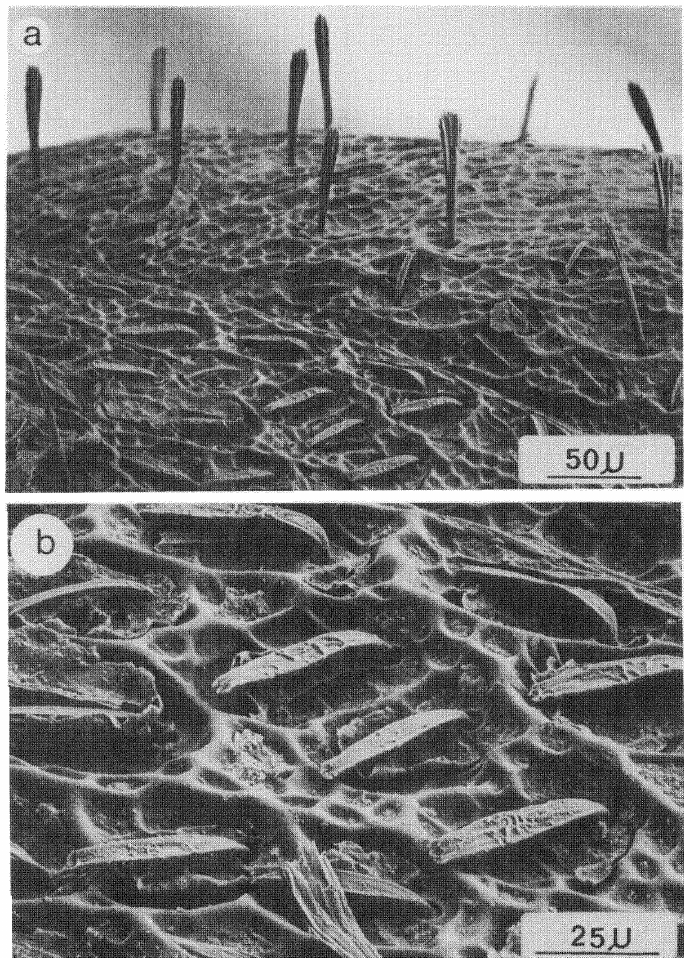
Fig. 11. Z. setulifer (same individual as Fig. 10). Thorax. a. Erect brush setae and second layer of holding setae appressed on surface, b. Holding